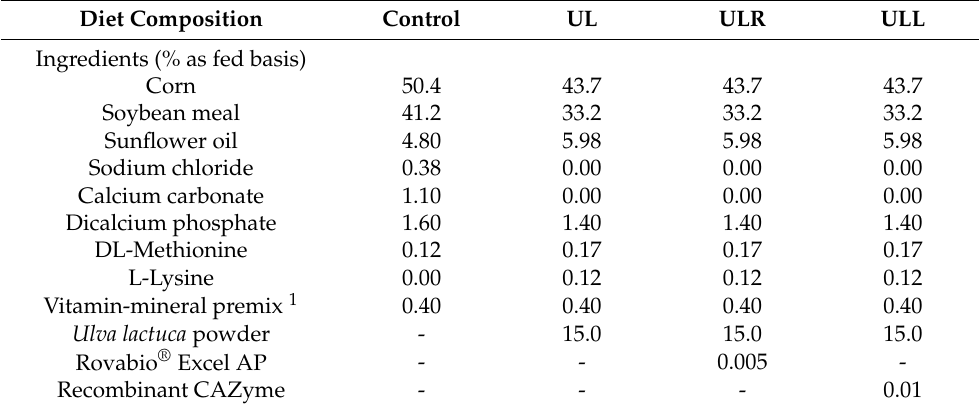
Table 6. Main ingredients of the experimental